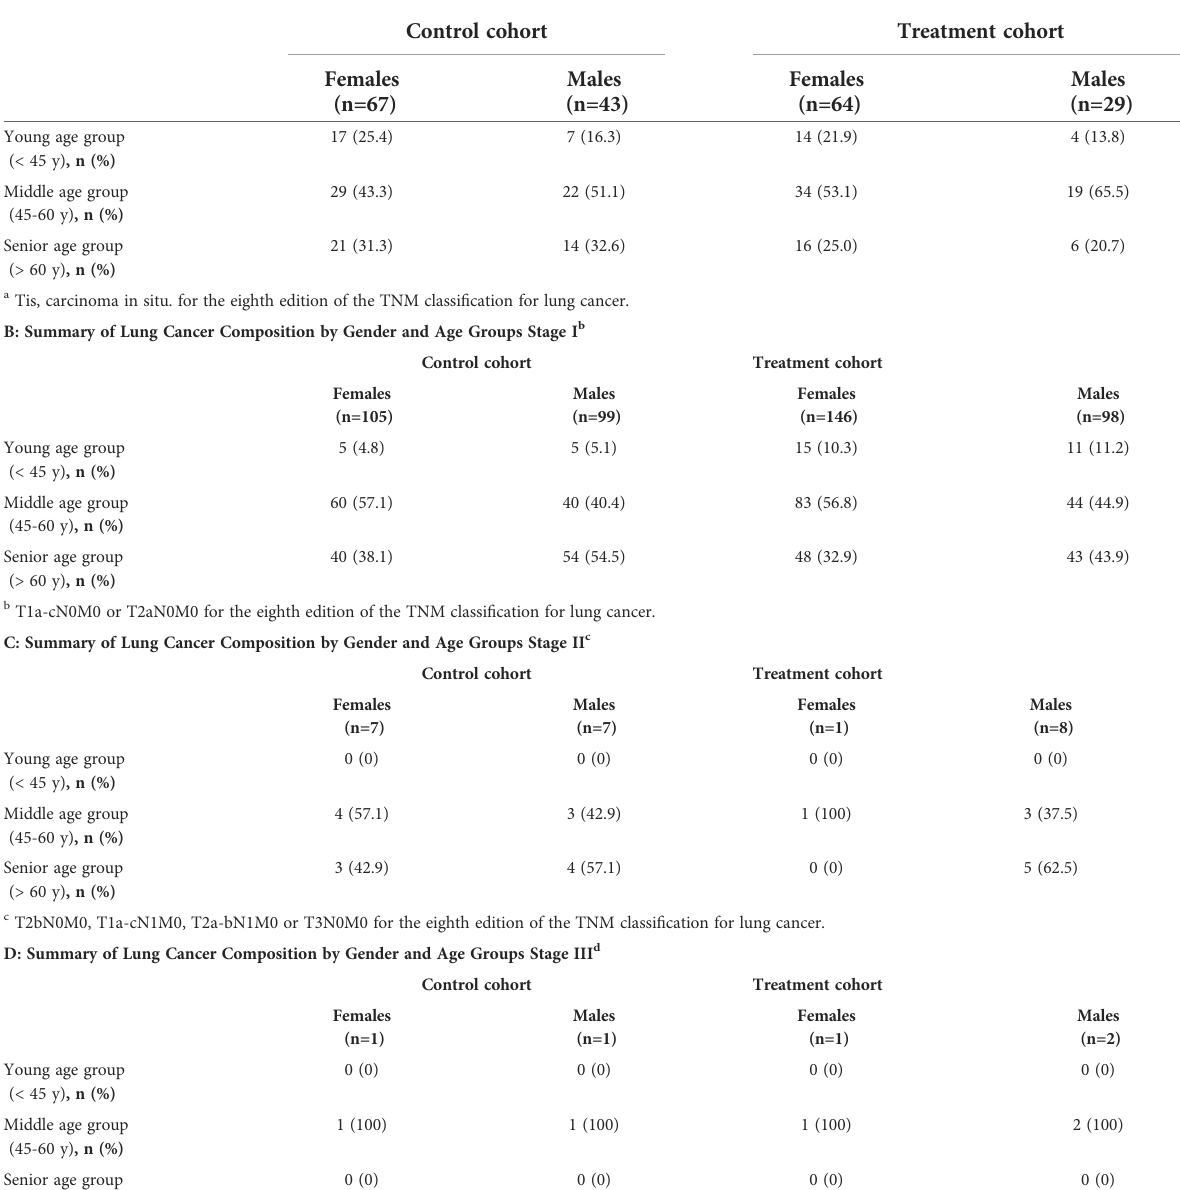
TABLE 5 A: Summary of Lung Cancer Composition by Gender and Age Groups Stage 0 a